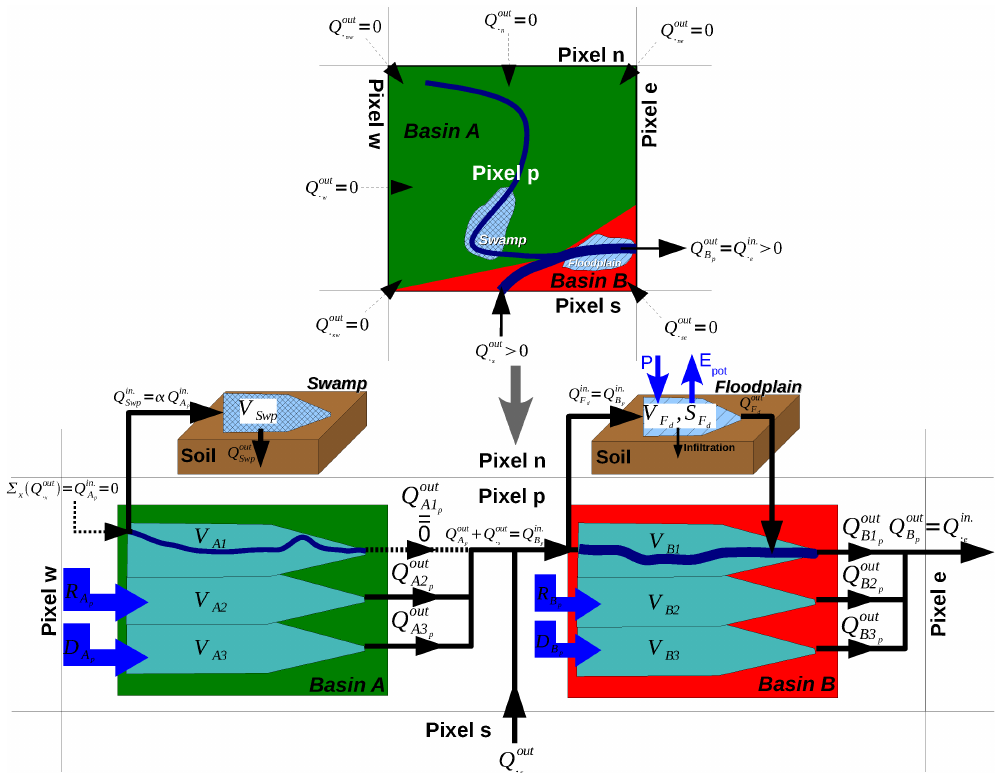
Fig. 1. Flow chart of the routing channel connected with floodplains/swamps module in ORCHIDEE. Example of two sub-basins A (with a swamp fraction) and B (with a floodplain fraction) included into one grid cell p.